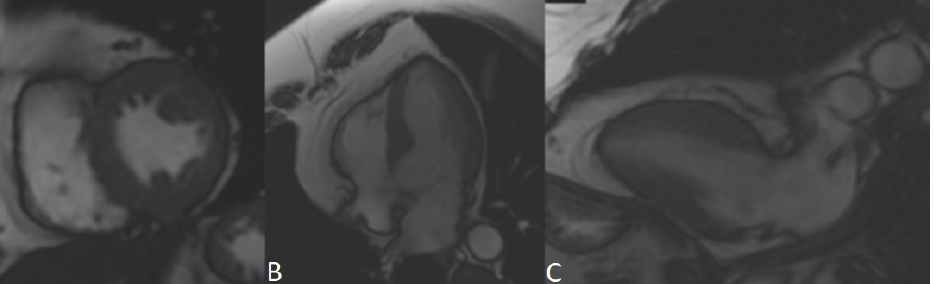
Figure 8. CMR patient III.13 Right ventricle with normal volumes: end-diastole volume 44 mL/m 2 and end-systole volume 21 mL/m 2 with preserved global systolic function, ejection fraction 52%. No late gadolinium enhancement. Four chambers; ( A ) Short axis; ( B ) Four chambers ( C ) Long axis.